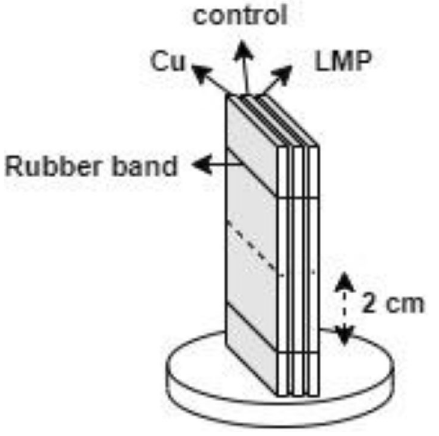
Figure 2. X-ray sample arrangement.